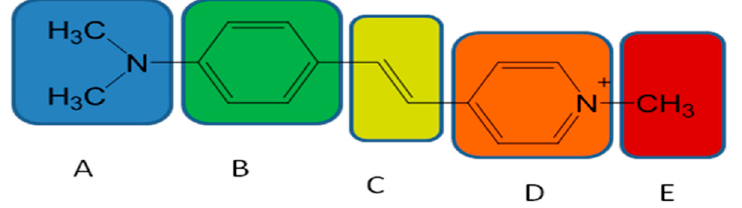
Figure 4. Molecular structure of the modification of DAST cation.